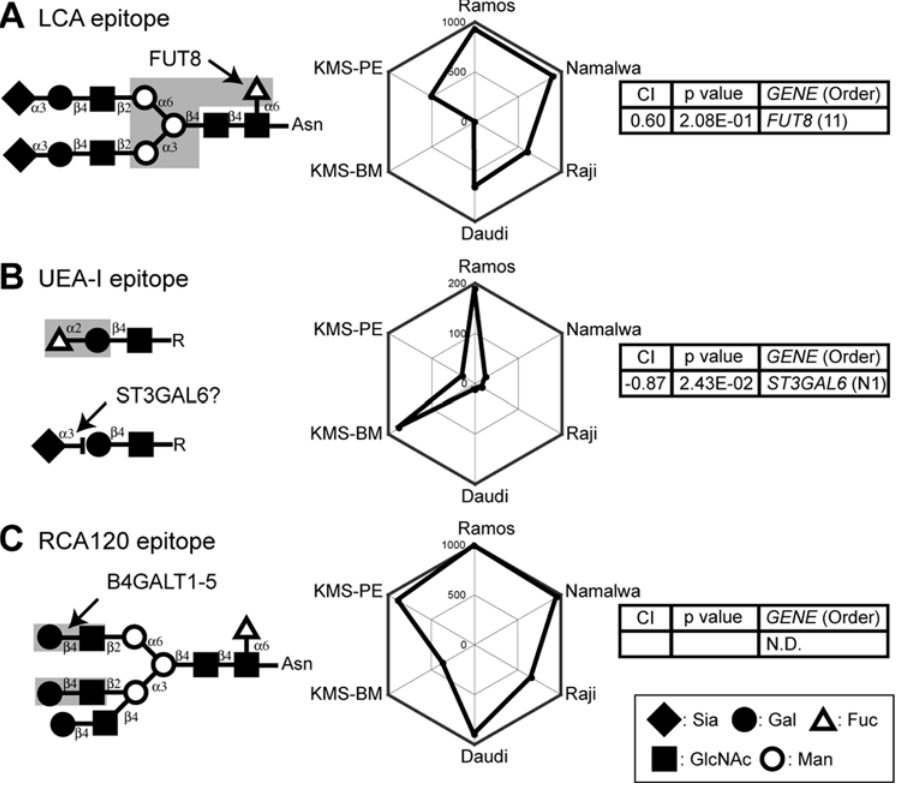
Figure 3. CIRES analyses of staining profiles obtained using lectins that recognize terminal glycan structures and have unknown epitope- expression-regulating enzymes. Presentation is the same as in Fig. 2 except that the plant lectins used were (A) LCA, (B) UEA-I, and (C) RCA 120. N.D. in the gene order list indicates that no gene was determined to have a correlation with the lectin staining.